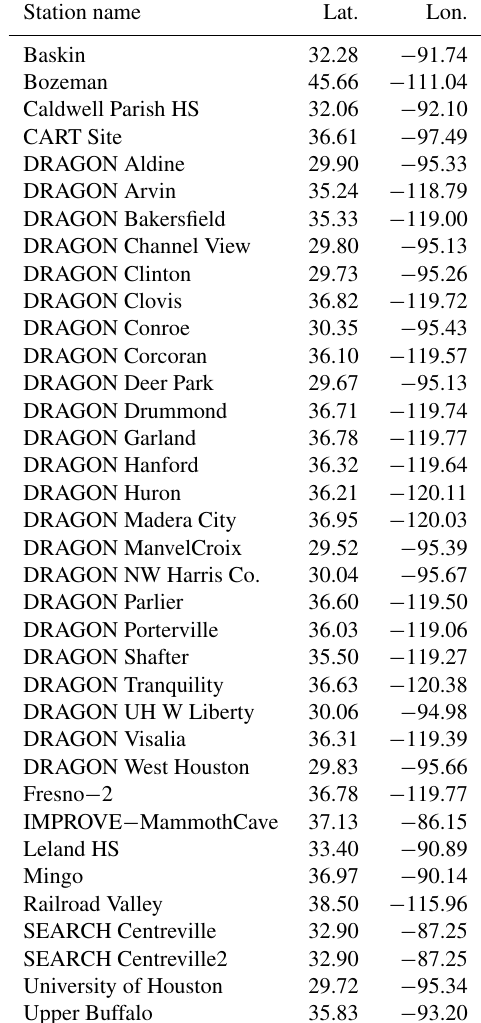
Table 4. List of the AERONET stations used for validation in this